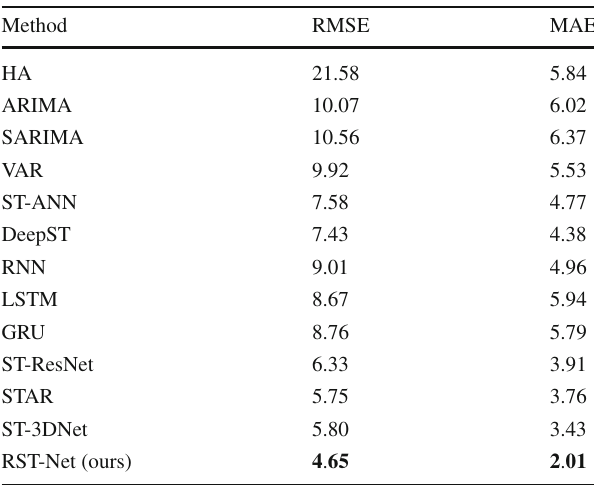
Fig. 10 Comparisons among different methods Table 2 Prediction results of RMSE and